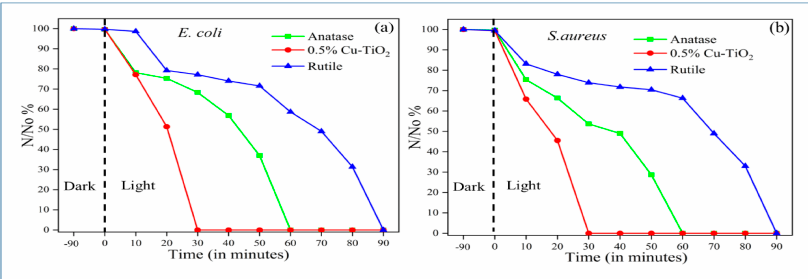
Figure 17. Photocatalytic inactivation of ( a ) E. coli and ( b ) S. aureus with 0.5% Cu/TiO 2 calcined at 650 °C, pure anatase and rutile specimens. N/N o is the reduction in the concentration of the bacteria. Reproduced with permission from [109]. Copyright MDPI, 2018.